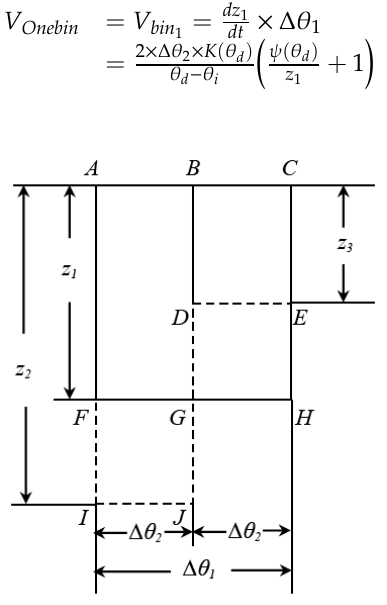
Figure 5. One bin versus two bins.